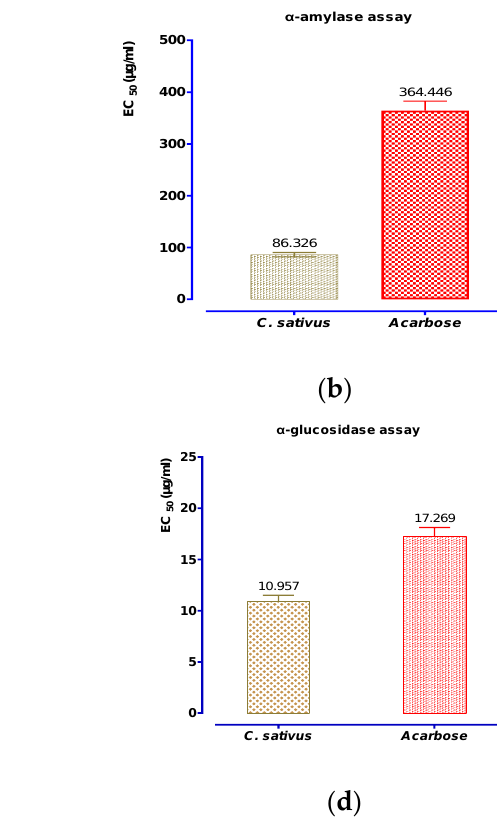
Figure 9. Percent inhibition and EC 50 of inhibitory effects on α -amylase ( a , b ) and α -glucosidase ( c , d ) activities by C. sativus decocted extract and acarbose, in vitro. Values are means ± SEM (n = 3).